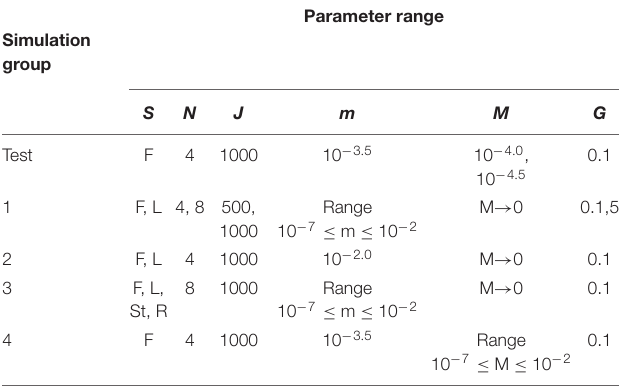
TABLE 2 | Parameters used for all groups of